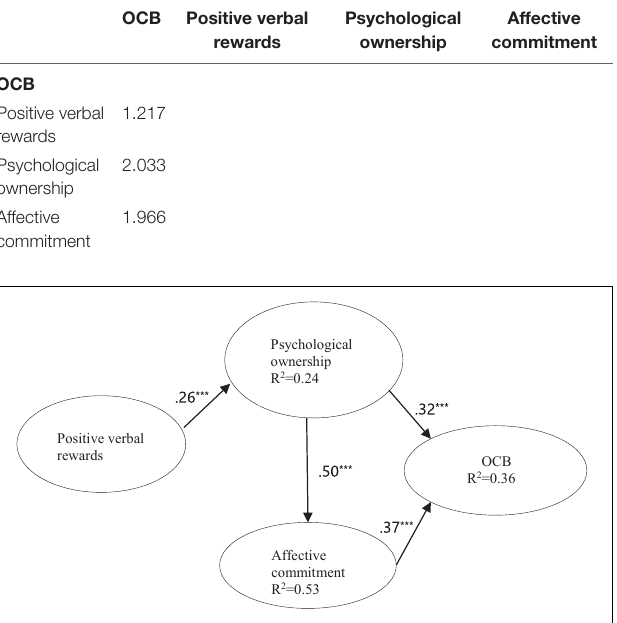
TABLE 4 | Collinearity scores based on the variance inflation factor test.